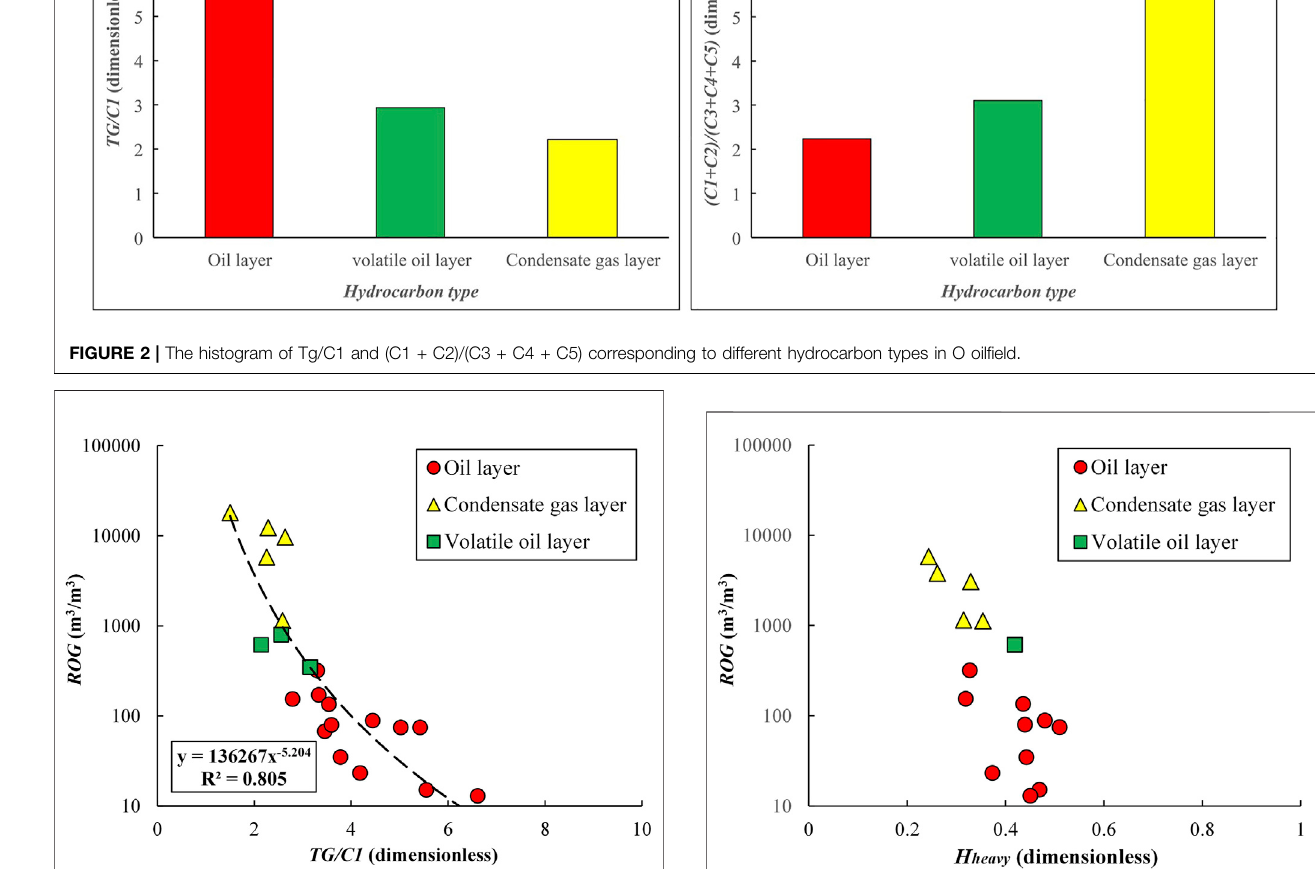
FIGURE 4 | The cross-plot between production gas-oil ratio with H heavy .